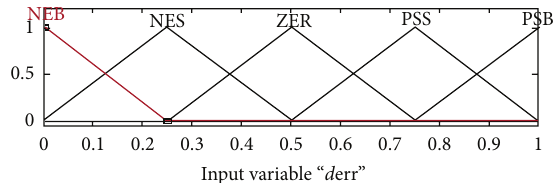
Figure 10: Membership function of fuzzy logic controller for input derivative error.